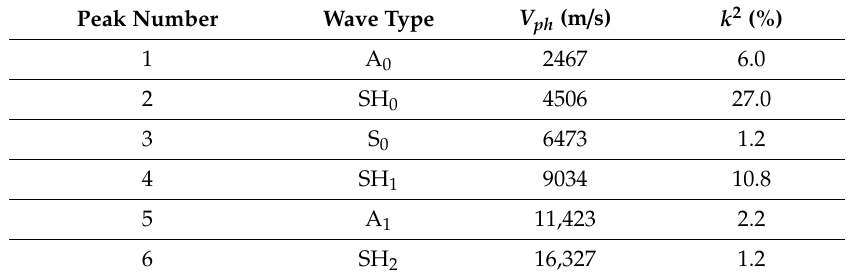
Table 3. Calculated V ph and k 2 of the plate acoustic waves propagated in YX LiNbO 3 plate. Peak Number